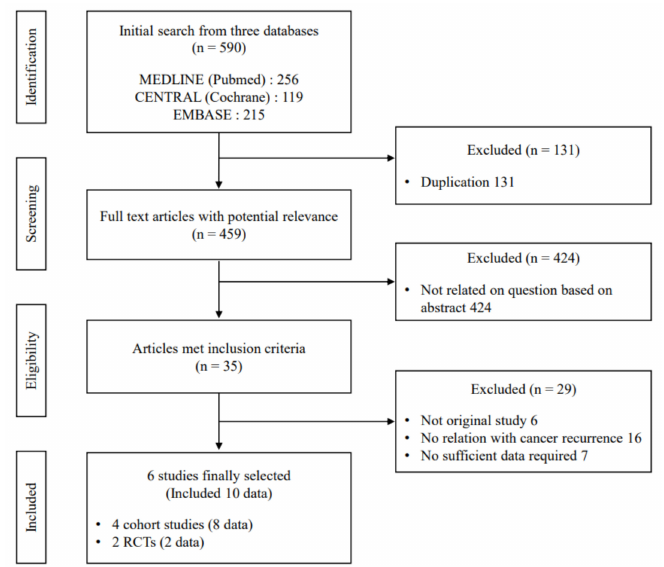
Figure 1. Flow diagram of literature search